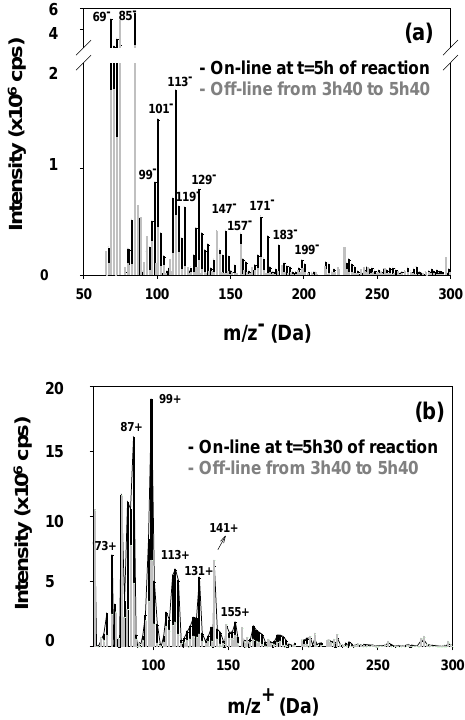
45 Figure 5 : TD-API-AMS measurements (a) in the negative mode and (b) in the positive mode 46 of the chemical composition of SOA formed during isoprene photooxidation (experiment 1). 47 Fig. 5. TD-API-AMS measurements (a) in the negative mode and Comparison of the mass spectra obtained i) by direct on-line measurement in the smog 48 (b) in the positive mode of the chemical composition of SOA chamber (in black), and ii) by nebulization of “control” samples (in grey). 49 formed during isoprene photooxidation (experiment 1). Compari- son of the mass spectra obtained (i) by direct on-line measurement in the smog chamber (in black), and (ii) by nebulization of “control” samples (in grey).